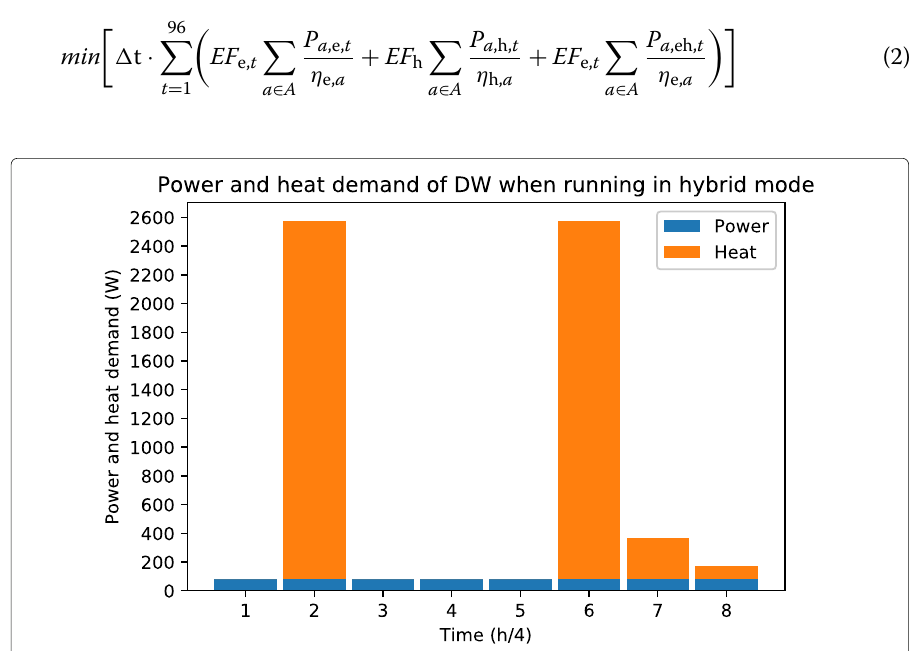
Fig. 4 Example of demand profiles of a hybrid appliance (DW): hybrid mode (Stamminger et al.